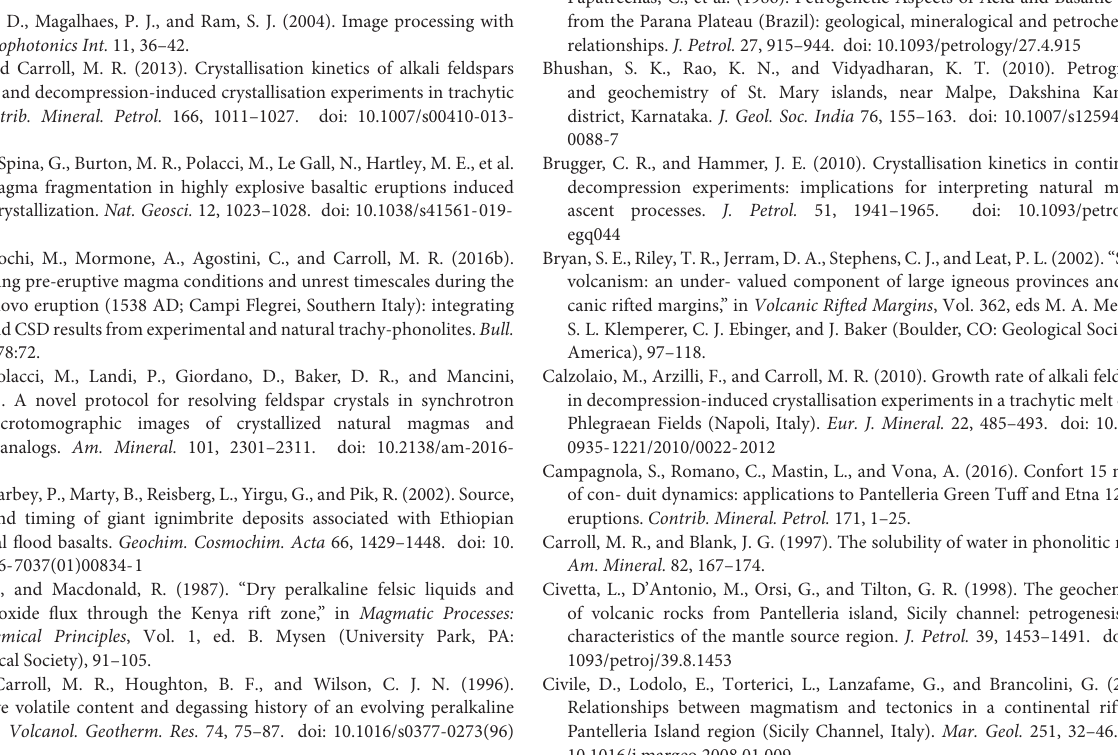
FIGURE S1 | H 2 O solubility in peralkaline rhyolitic melt as a function of pressure, calculated following Papale et al. (2006). The maximum amount of H 2 O estimated by model of Papale et al. (2006) as a function of pressure is considered the H 2 O content dissolved in the melt to reach the water-saturated conditions in this study.